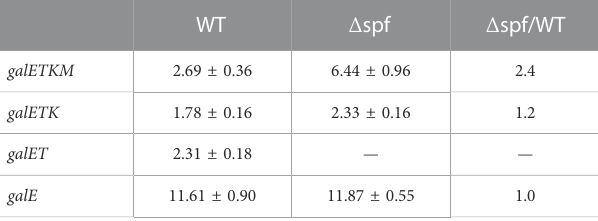
TABLE 1 The half-life of the 5 9 -sharing mRNA. These were measured from the E-probed blots. The values are the average of three independent experiments.